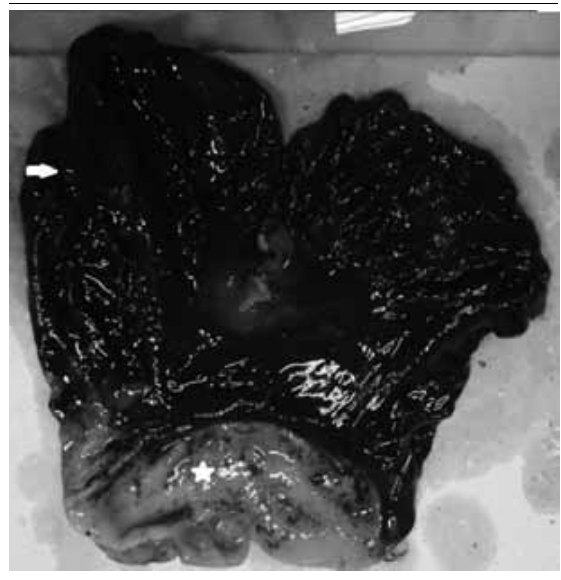
figurE 4 – Macroscopic aspect of the opened stomach of the same rabbit of Figure 3 after 12 hours of gastric ischemia: presence of diffuse hemorrhagic necrosis in the body and fundus regions (arrow), whereas the antral region (*) is